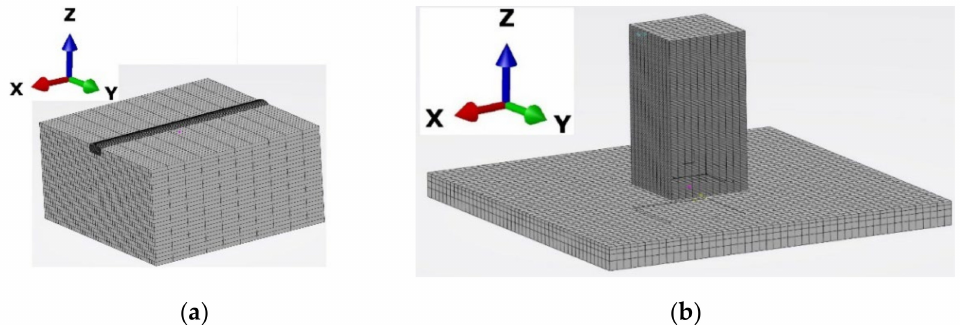
Figure 2. FEM meshed model: ( a ) Single-track; ( b ) Solid 3D structure. Linear heat transfer elements (DC3D8) were selected for the thermal simulation. Linear elements (C3D8) from the 3DExperience library were used for mechanical analysis. The FE model for the 3D solid structure consists of 28,576 elements (2 mm mesh size) and 35,189 nodes depicted in Figure